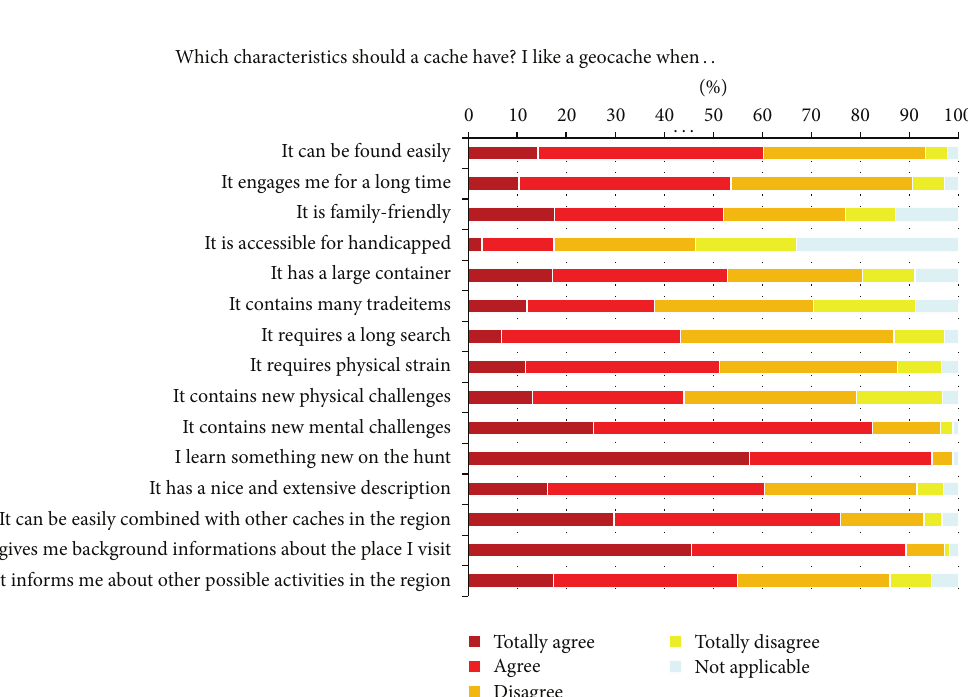
Figure 5: Motivation of geocachers.